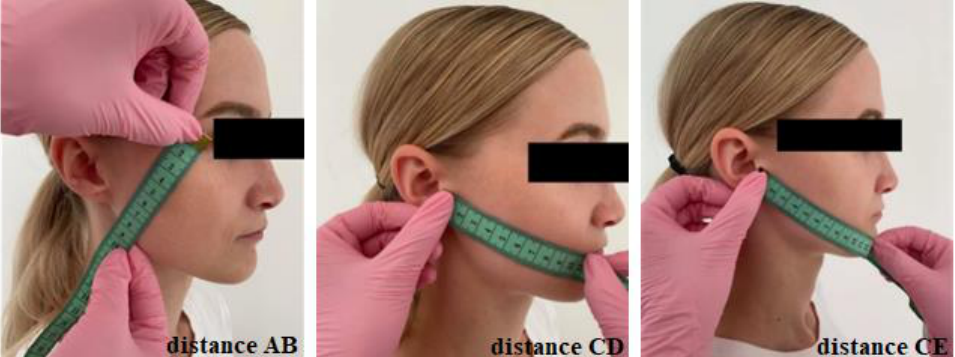
Figure 1. Edema measurement. Distance AB (between the eye ’ s external canthus and gonion), distance CD (between tragus and cheilion), and distance CE (between tragus and gnathion).